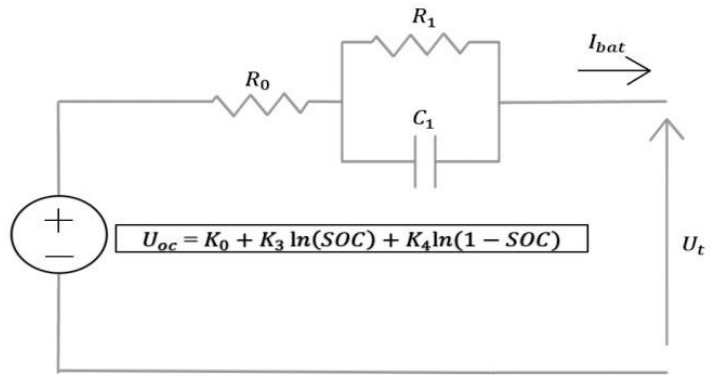
Figure 1. Thevenin equivalent circuit model with Nernst OCV–SOC relation used as the baseline model for comparison against Model I.